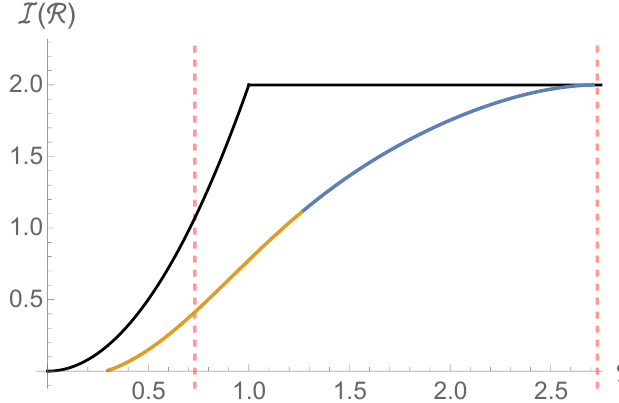
Figure 15. Two-sided mutual information for the d = 3 RN black brane with q = 3 = 4, which does not give continuous saturation in the one-sided setup. On (cid:12)gure 9 it corresponds to the red curve with the largest cusp. Besides (5.13), we have plotted for = 4, and marked the points (5.14) I T (saturates) = v with dashed red lines. While saturates at the point B T + 1, it starts is nonzero I R earlier than what we get for black branes with continuous saturation. Also, while the curve starts I with zero slope on (cid:12)gure 14, here the slope is